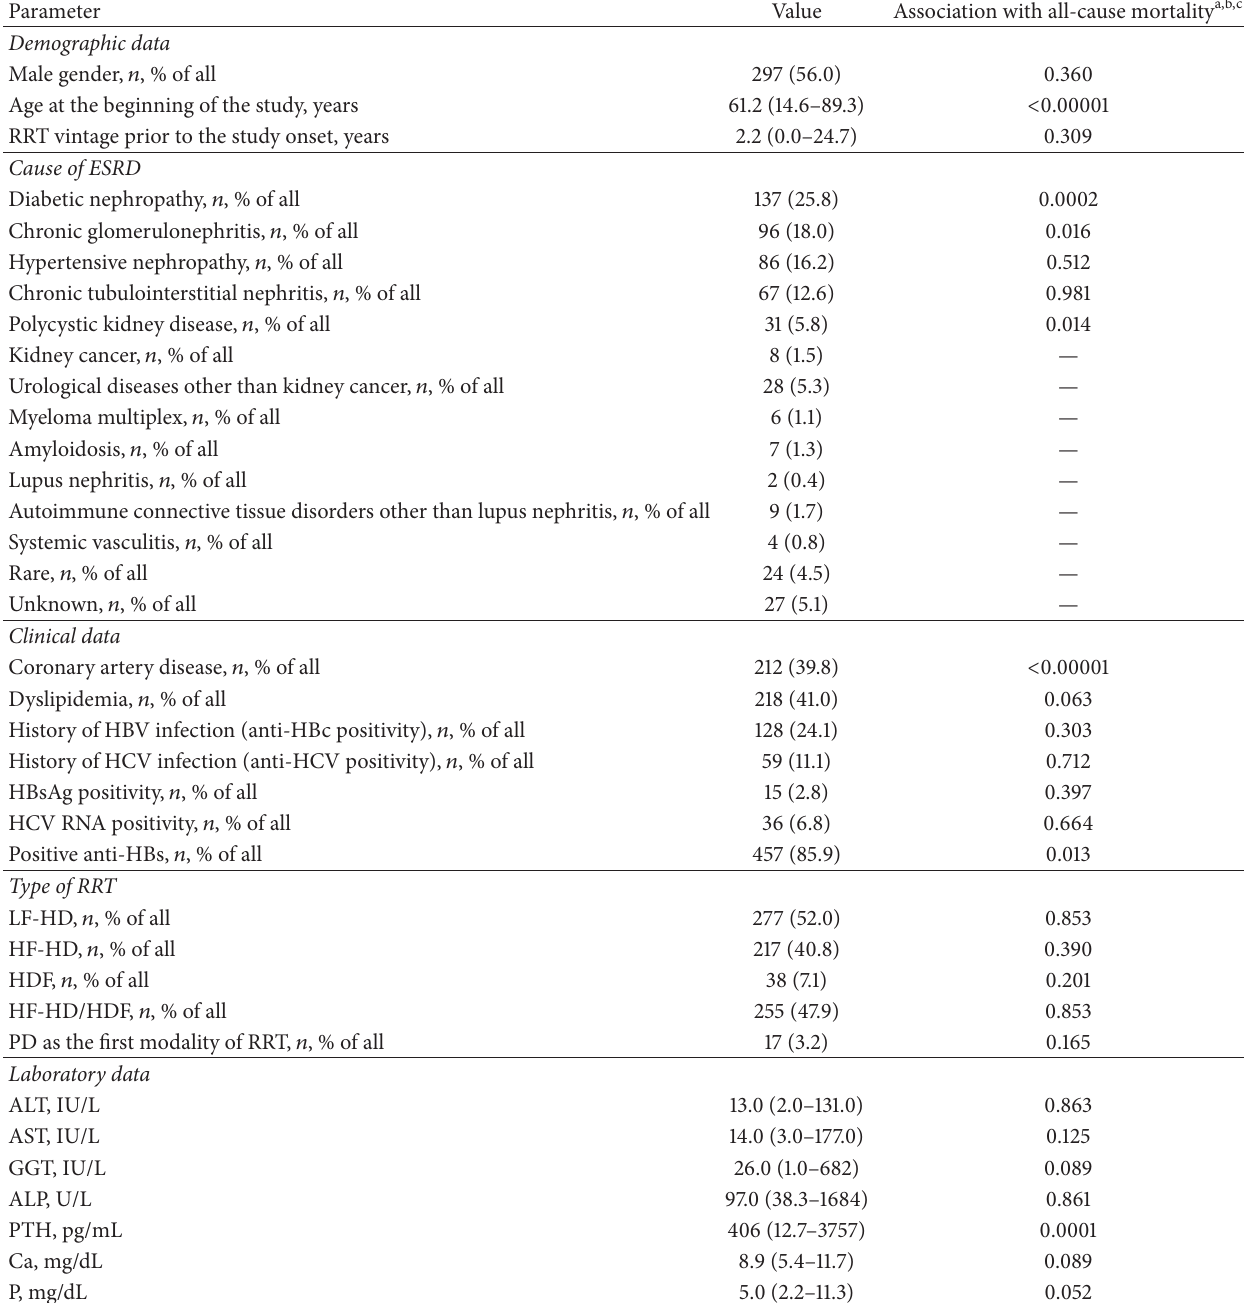
Table 1: Demographic, clinical, and laboratory characteristics of hemodialysis patients at enrolment into a prospective study ( 𝑛 = 532 ) and their association with all-cause